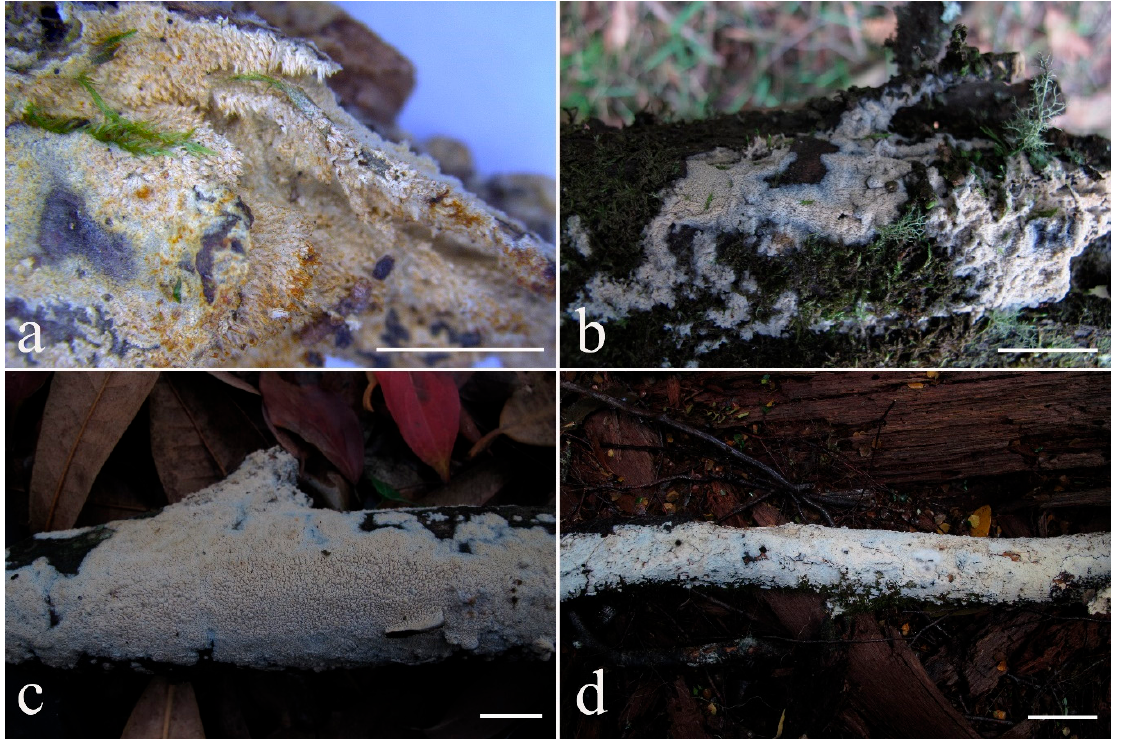
Figure 8. ( a ) Basidiocarps of Kneiffiella eucalypticola , ( b ) LWZ 20180509-11 (holotype); ( c ) LWZ 20180512-7 (paratype); ( d ) LWZ 20180515-9 (paratype).—Scale bars: a = 5 mm; b , c = 1 cm; d = 2 cm.